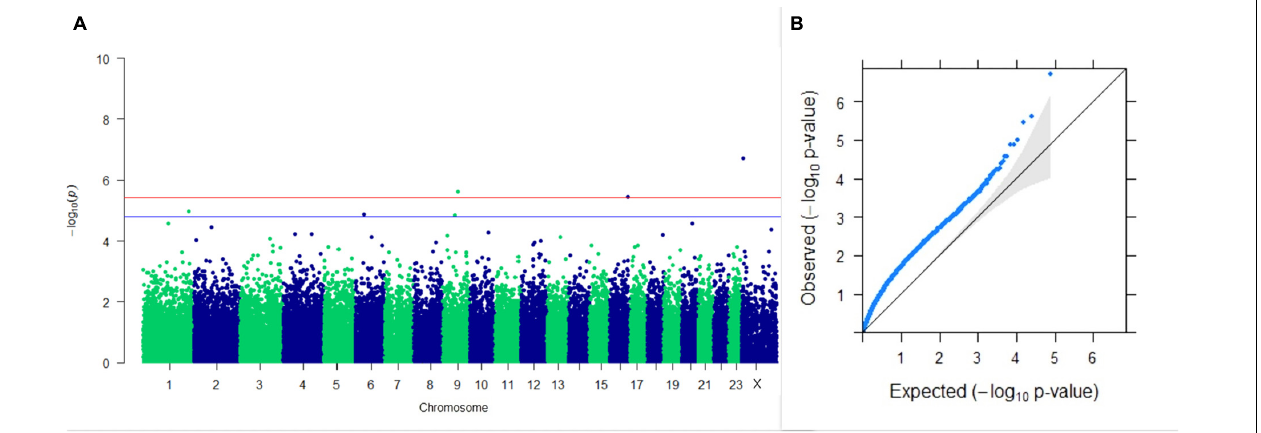
FIGURE 1 | Results of GWAS for PC1 of the test day’s milk yield. (A) Manhattan plot of genome-wide SNPs. The red line indicates the p- value threshold (expressed as –log 10 P ) corresponding to FDR-corrected p- values or q = 0.05, above which the SNPs are considered to be significantly associated with the trait, while the blue line indicates the genome-wide suggestive threshold at q = 0.1. The SNPs identified on chromosome no. 24 were screened out from analysis because of stringent quality control; hence, it is not represented in the Manhattan plot. (B) Q-Q plot of the p- values.